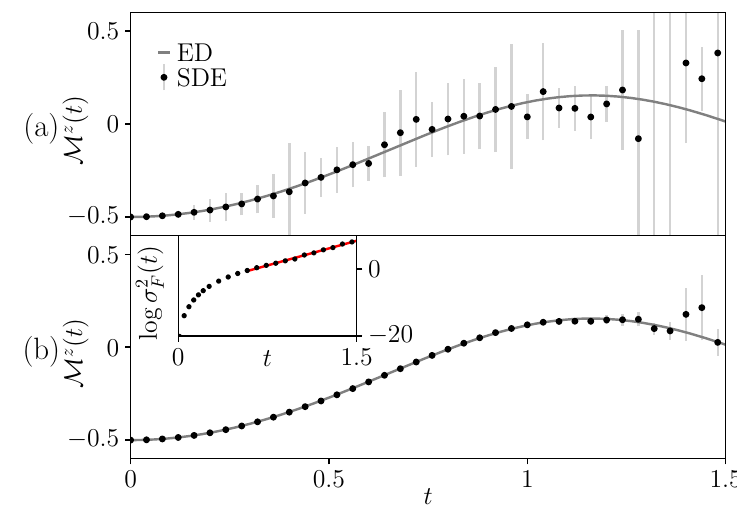
z of the 2D Ising Figure 2: Time evolution of the longitudinal magnetization M model (13) following a quantum quench. We consider a 3 × 3 system initialized in the |⇓〉 state and evolved using the Hamiltonian (13) with Γ = h = 2 J . We com- pare the results obtained by solving the Ising SDEs (dots) using (a) direct sampling and (b) importance sampling, showing ED (full lines) as a benchmark. Each data set = 10 4 trajectories. The error bars signal the much stronger and more consists of N rapidly growing fluctuations for direct sampling. The inset of panel (b) illustrates the exponential growth of fluctuations in the stochastic quantities with time; the solid red line shows the fit given in the main